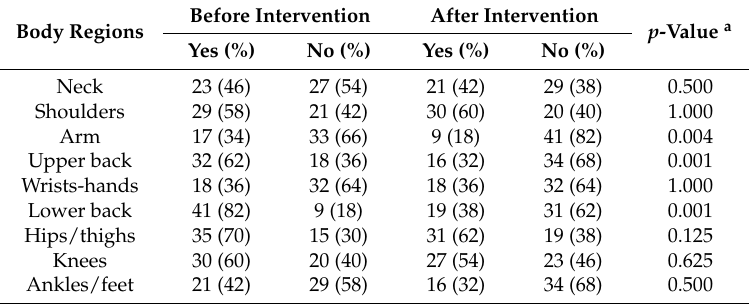
Table 2. Prevalence rate of reported MSDs in different body regions of case subjects before and after intervention ( n = 50).